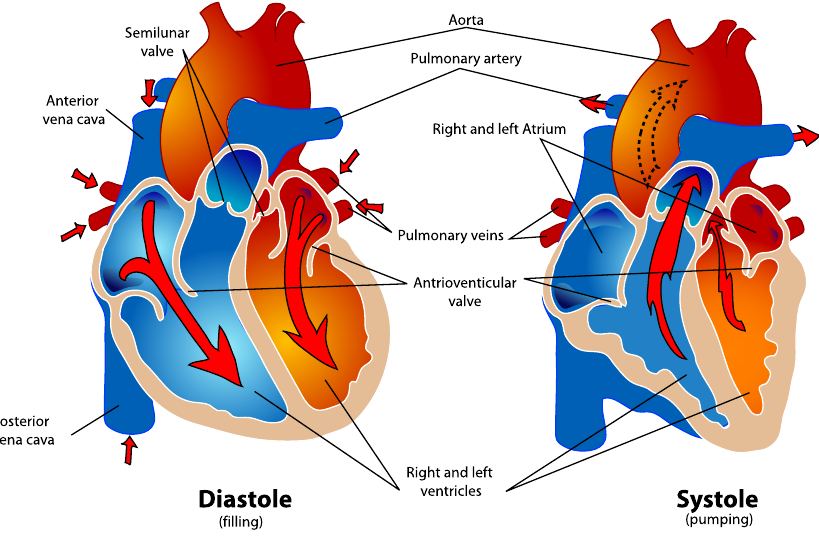
Figure 1. Schematic illustration of the human heart